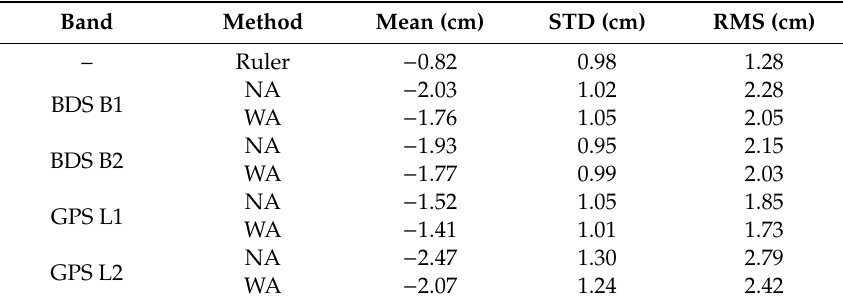
Figure 11. Scatterplot of in situ SWE versus SNR-based SWE estimates ( left ), and scatterplot in situ snow depth versus SNR-based snow depth estimates ( right ). NA stands for normal average and WA stands for weighted average. Table 5. Mean, STD and RMS of errors in SNR-based SWE estimation.